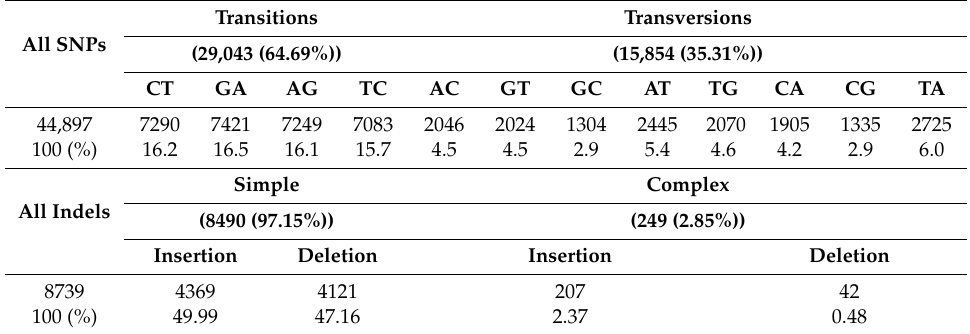
Table 4. Summary of putative single nucleotide polymorphism (SNP) and Indel